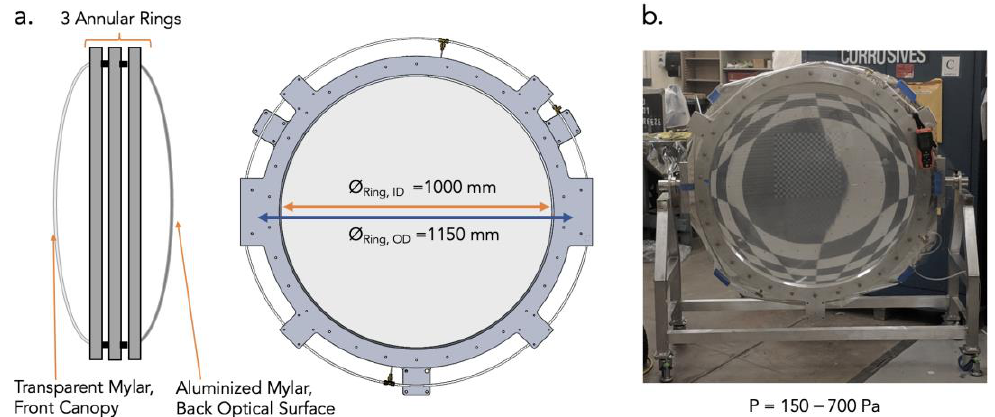
Figure 1. An inflatable membrane mirror is constructed by clamping two Mylar sheets between three machined aluminum rings (a). During inflation, the rear aluminized Mylar becomes the concave reflecting surface of interest, while the clear convex Mylar front surface helps hold pressure (b). The convex Mylar surface is known as the canopy. In the final full-sized assembly, the canopy will be black polyimide, which is opaque in the visible but transparent with some loss in the target operation wavelengths (~80 – 660 µm).